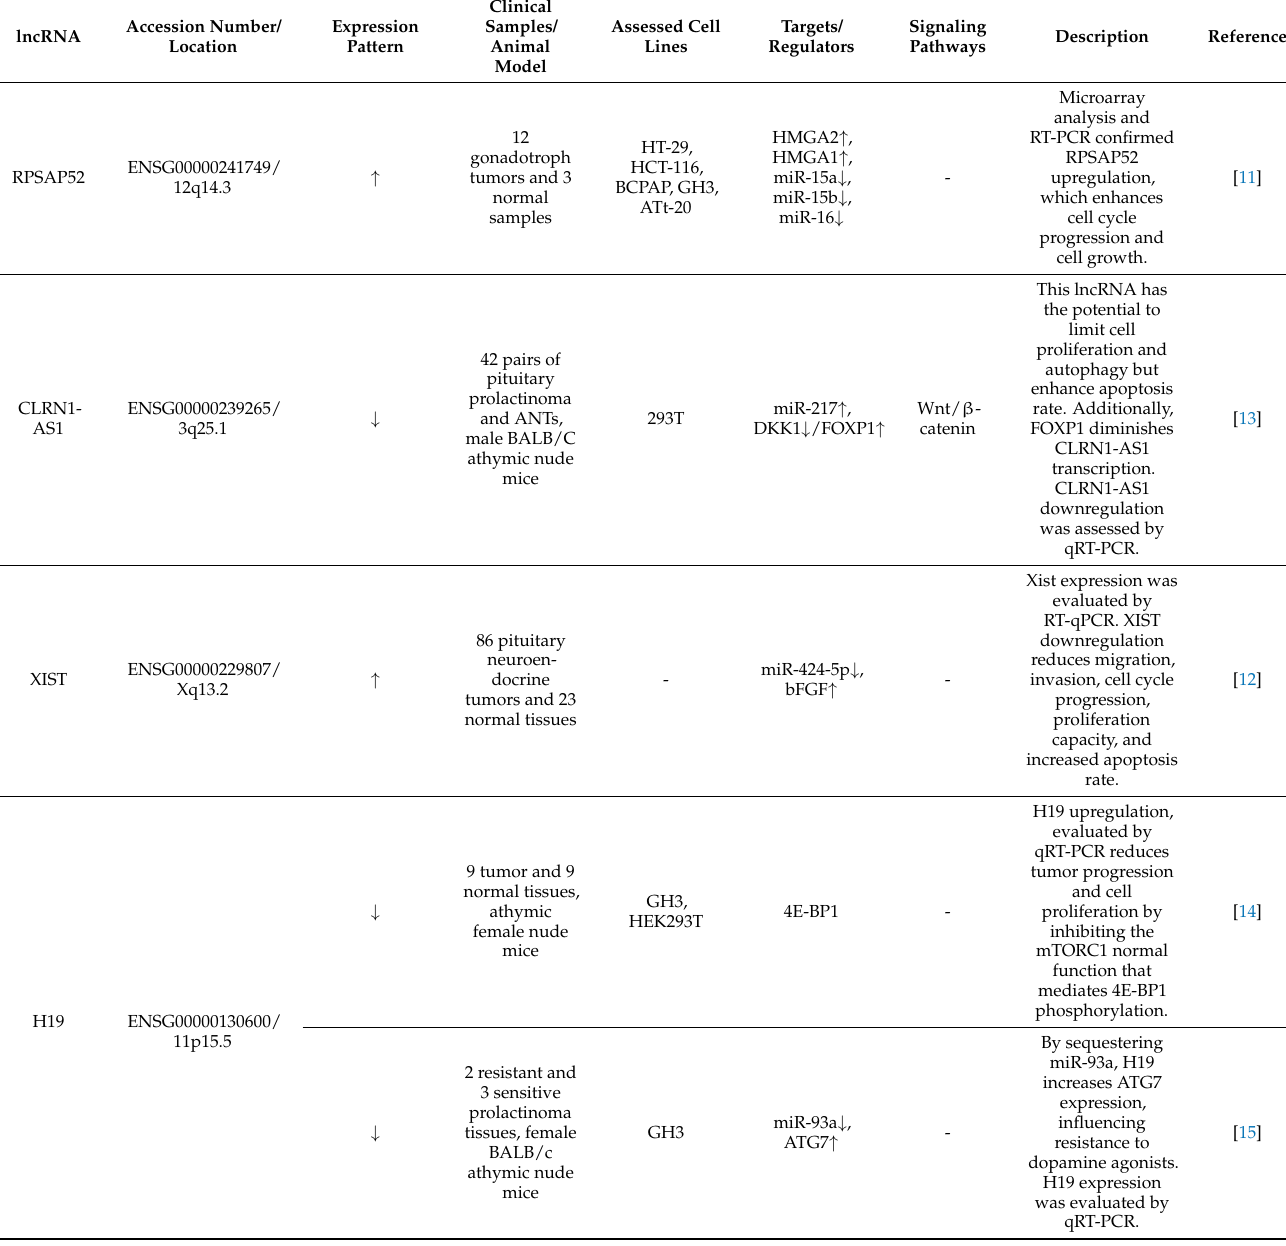
Table 1. LncRNAs and pituitary gland tumors (ANTs: adjacent non-tumor